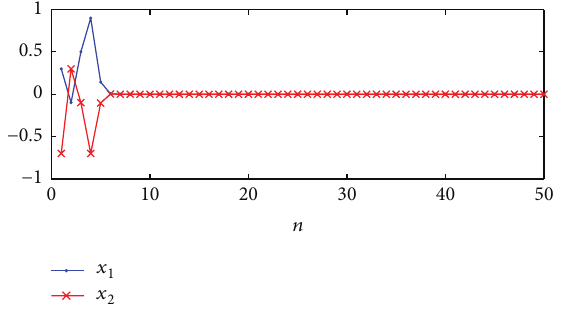
Figure 4: The response curves of system (39) with impulsive effects ( 𝛾 = 0.0256 ).